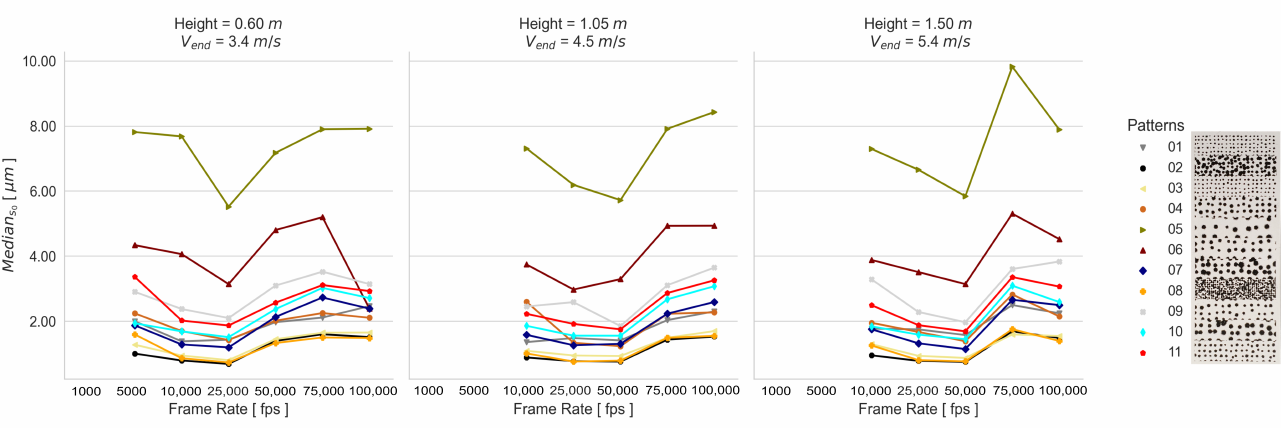
Figure 10. Median s 0 of the transformations obtained from the dynamic SP experimental